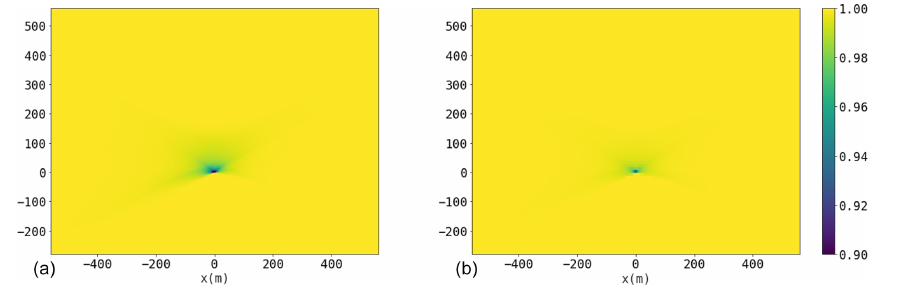
Figure 3. Heat maps of POA loss (a) and PV power loss (b) for a year at (33.209 ◦ , − 108 . 283 ◦ ), simulated at 15min intervals with 12 blade angles per step for a 77m diameter turbine at (0,